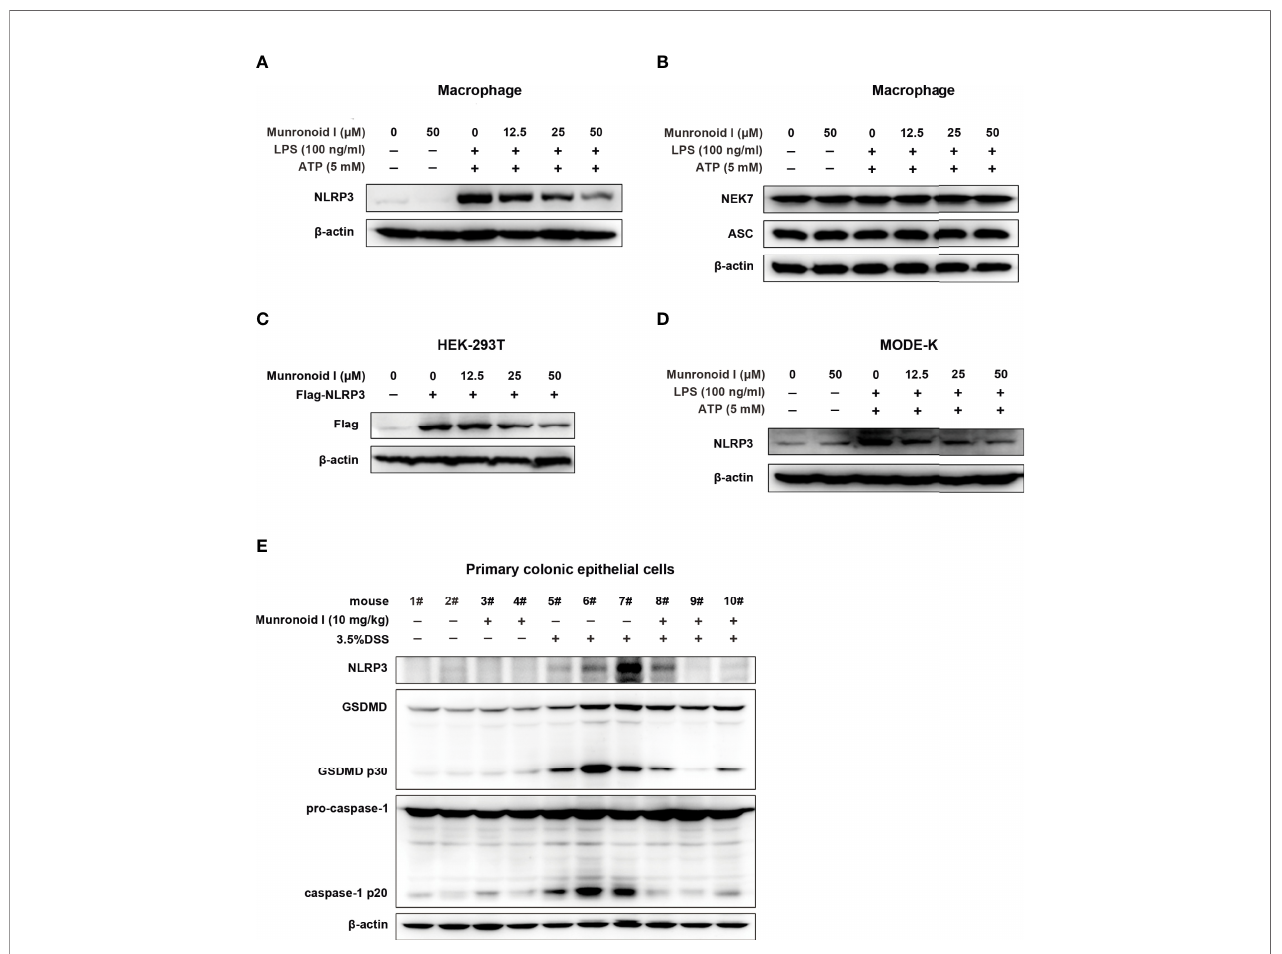
FIGURE 6 | Munronoid I downregulated the protein level of NLRP3 in macrophages and MODE-K cells stimulated with LPS/ATP. (A, B) Mouse peritoneal macrophages were pretreated with DMSO or different concentrations of Munronoid I (12.5 m M, 25 m M, 50 m M) for 2 h, following stimulation with LPS (100 ng/ml) for 4 h, and then treated with ATP (5 mM) for 30 min. The cell lysate was collected and Western blot was performed to detect NLRP3 (A) , NEK7 and ASC (B) . (C) Plasmid Flag-NLRP3 was transfected into HEK293T cells. DMSO or different concentrations of Munronoid I (12.5 m M, 25 m M, 50 m M) were added the cells for 4 h, Western blot analysis of NLRP3 protein in cell lysates with antibody to Flag tag. (D) MODE-K cells were pretreated with DMSO or Munronoid I (12.5 m M, 25 m M, 50 m M) for 2 h, following LPS (2 m g/ml) stimulation for 4 h, and then treated with ATP (5 mM) for 30 min, NLRP3 protein were analyzed by Western blot. All the above data were from three independent experiments. (E) C57BL/6 mice (n = 4 – 5 mice/group) were fed with distilled water or water containing 3.5% DSS and were intragastric injected with DMSO or Munronoid I (10 mg/kg) daily. Seven days later, all the water was changed to distilled water, on the 8th day, the mice were sacri fi ced and their colonic epithelial cells were collected and Western blot was performed to detect NLRP3, caspase-1 and